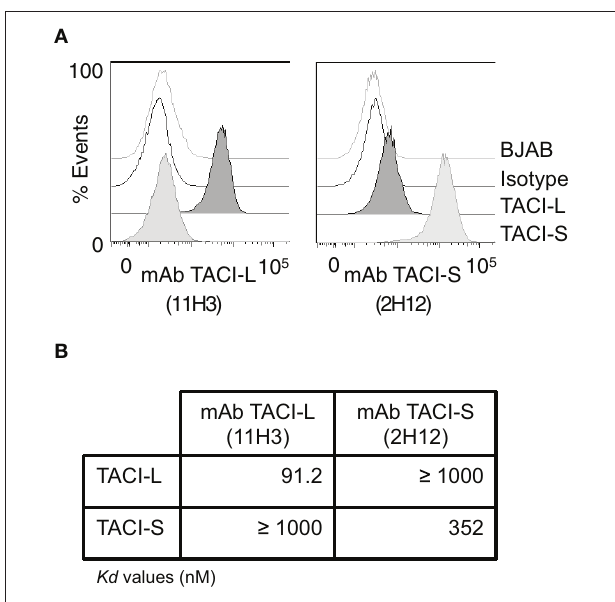
FIGURE 7 | Monoclonal Antibodies to TACI isoforms (A) representative FACS (LSRII) histograms showing the specificity of the mAbs to TACI-L and TACI-S, tested on BJAB-L and BJAB-S cells along with control isotype and un-transduced BJAB cells. TACI-L is identified by mAb clone 11H3 and TACI-S by mAb 2H12. (B) The binding affinity of t mAb to TACI-L and TACI-S isoforms was determined by Microscale thermophoresis (MST), showing the specificity of each antibody. The change in the thermophoretic signal produces K d values (nM); lower indicating greater affinity. Data represent the mean and SD of three independent thermophoresis